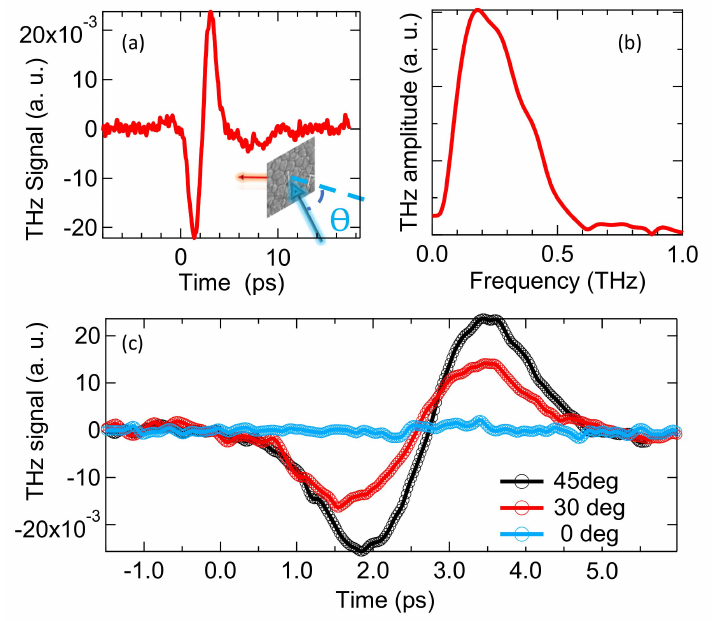
Figure 3. ( a ) Time − domain THz electric field emitted by MAPbI 3 thin film sample with Pb(SCN) 2 additive; ( b ) the corresponding Fourier spectrum of the emitted THz field exhibiting a main broad peak centered at ∼ 0.3 THz; ( c ) THz emission signal at a few excitation angles θ (illustrated in the inset of ( a )) relative to the normal to the